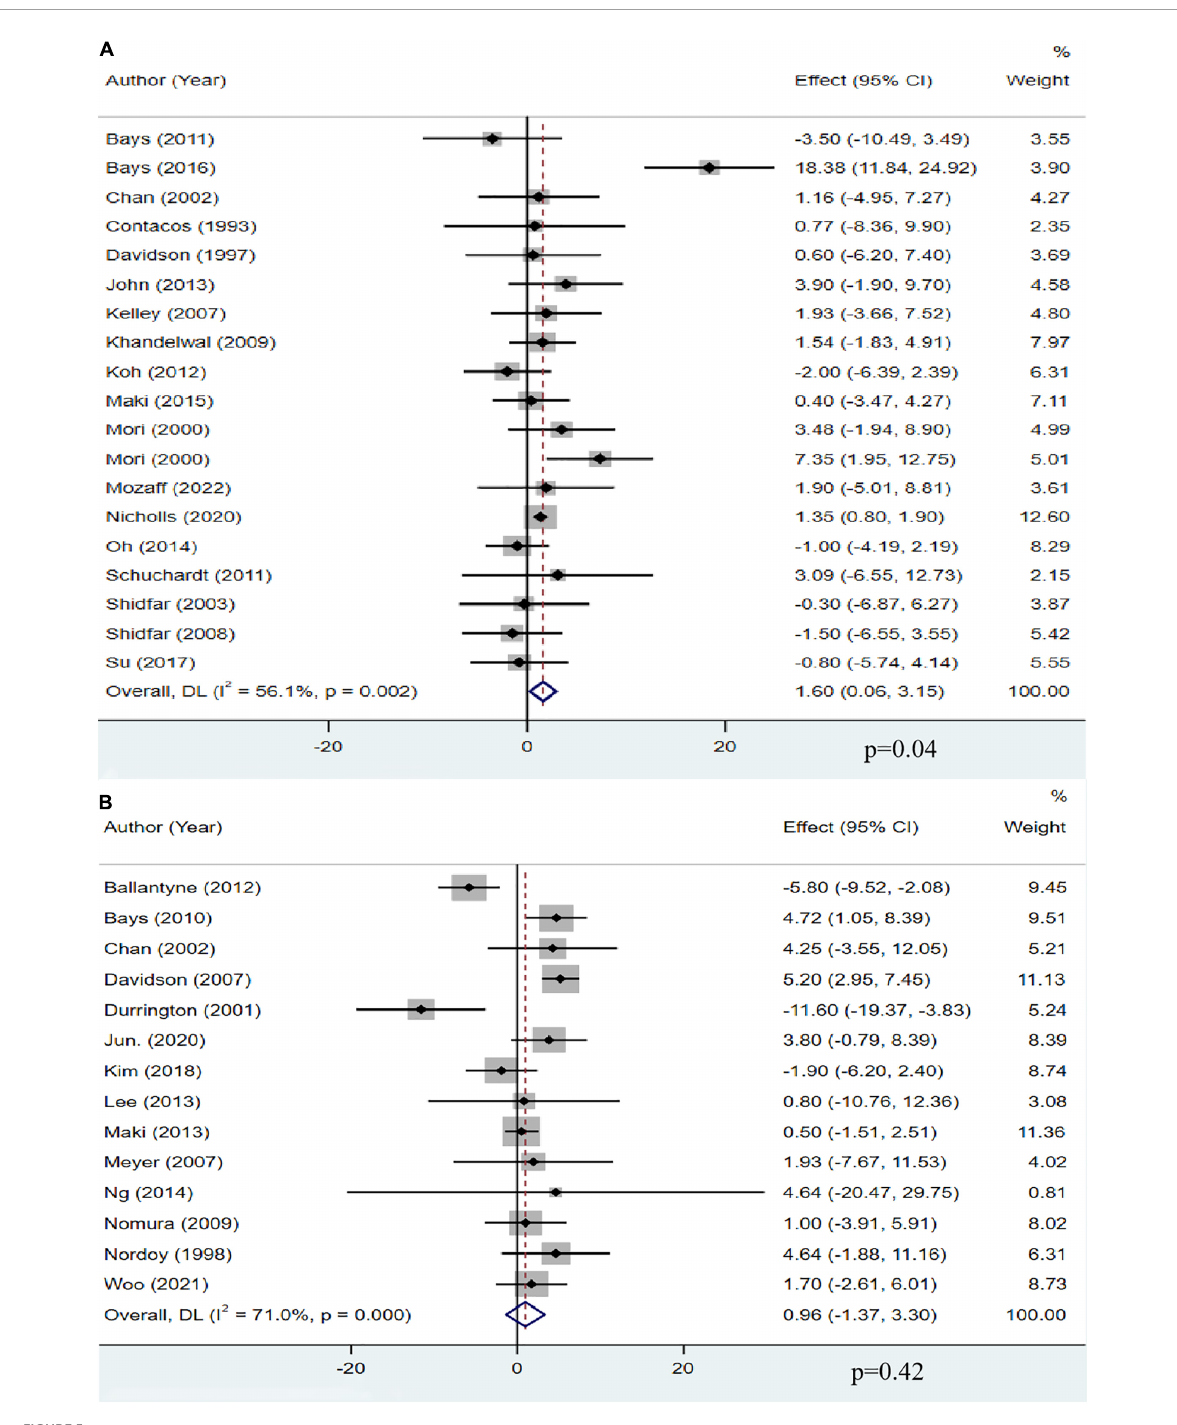
FIGURE5 The effect of OM3-FA on HDL-C. (A) OM3-FA monotherapy; (B) Combined therapy of statins plus OM3-FA.